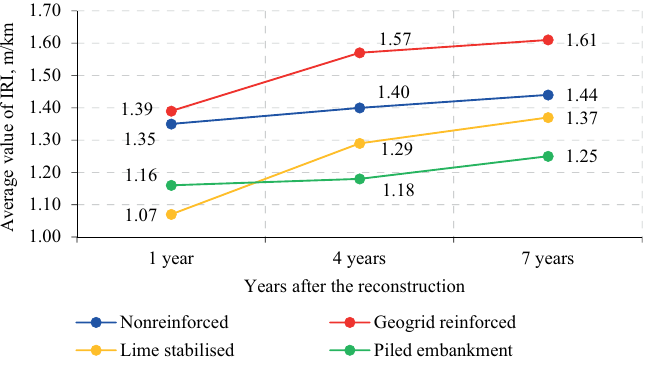
Figure 11. Average values of the International Roughness Index